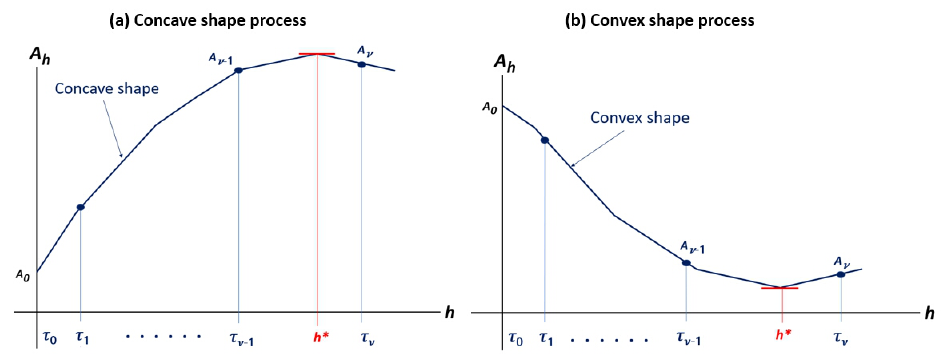
Figure 1. Convex shape and concave shape